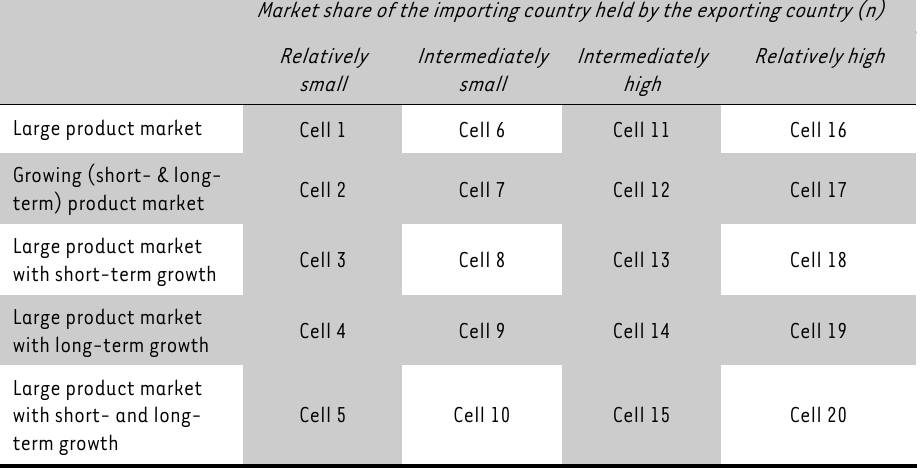
Final categorisation of high-potential export opportunities in DSM Market share of the importing country held by the exporting country (n) Relatively Intermediately Intermediately Relatively high small small high Cell